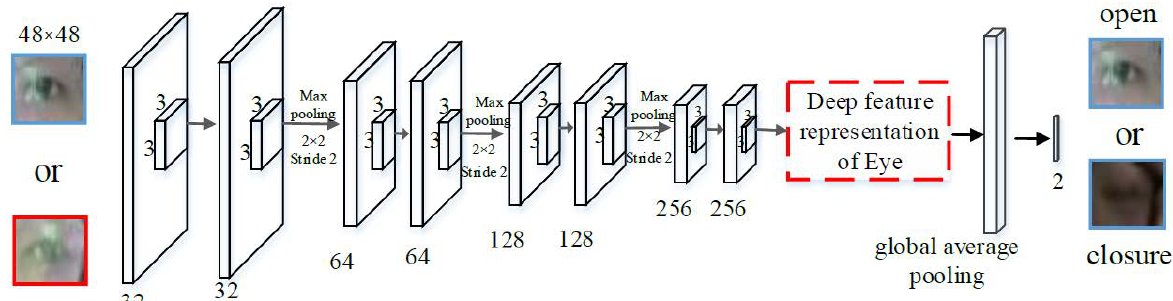
Figure 4. Illustration of the eyes state detection model. The red boxes drawn with a dotted line define the extracted deep features representation of the eyes. The numbers next to the boxes illustrate the dimensionality and structural detail of the kernel in each convolutional